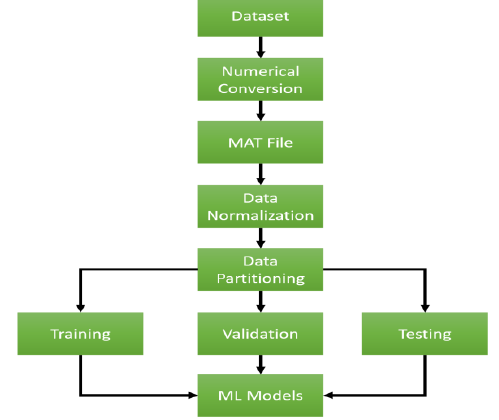
Figure 12. Data pre-processing.